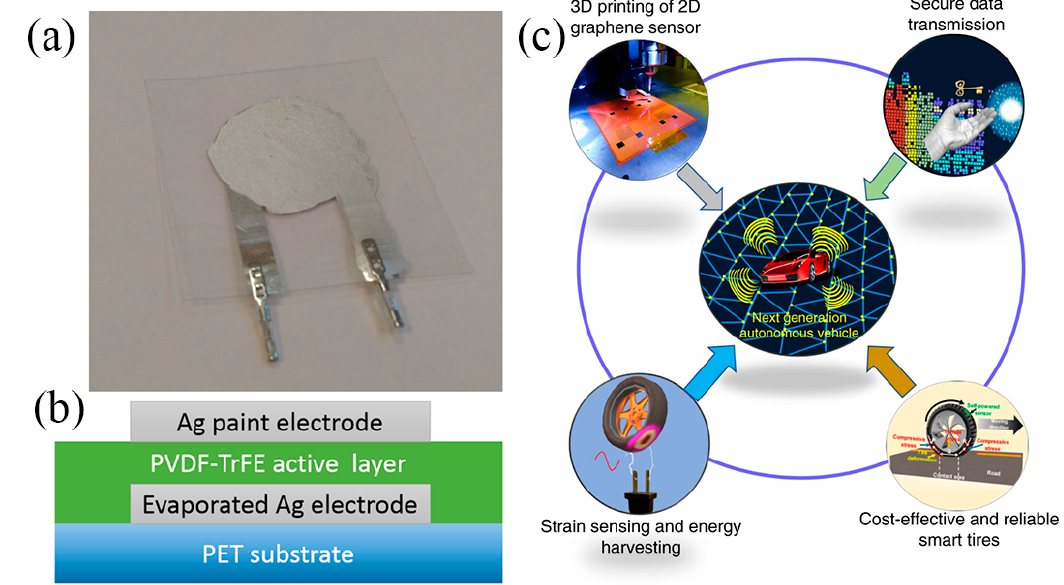
Figure 20. ( a ) A P(VDF-TrFE)-Ag sensor on PET substrate and ( b ) its cross-section (reproduced with permission from [72] copyright 2015, American Chemical Society); ( c ) a printed rGO strain sensor powered by PVDF integrated on a standalone tire monitoring system (reproduced with permission from [75], copyright 2020, Springer-Nature).